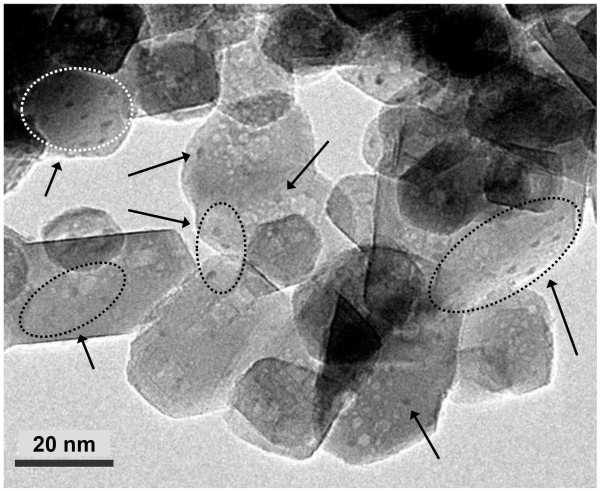
TEM image of the (CH3CH2NH3)PbI3-deposited TiO2nanoparticles. Arrows indicate (CH3CH2NH3)PbI3 nanodots.